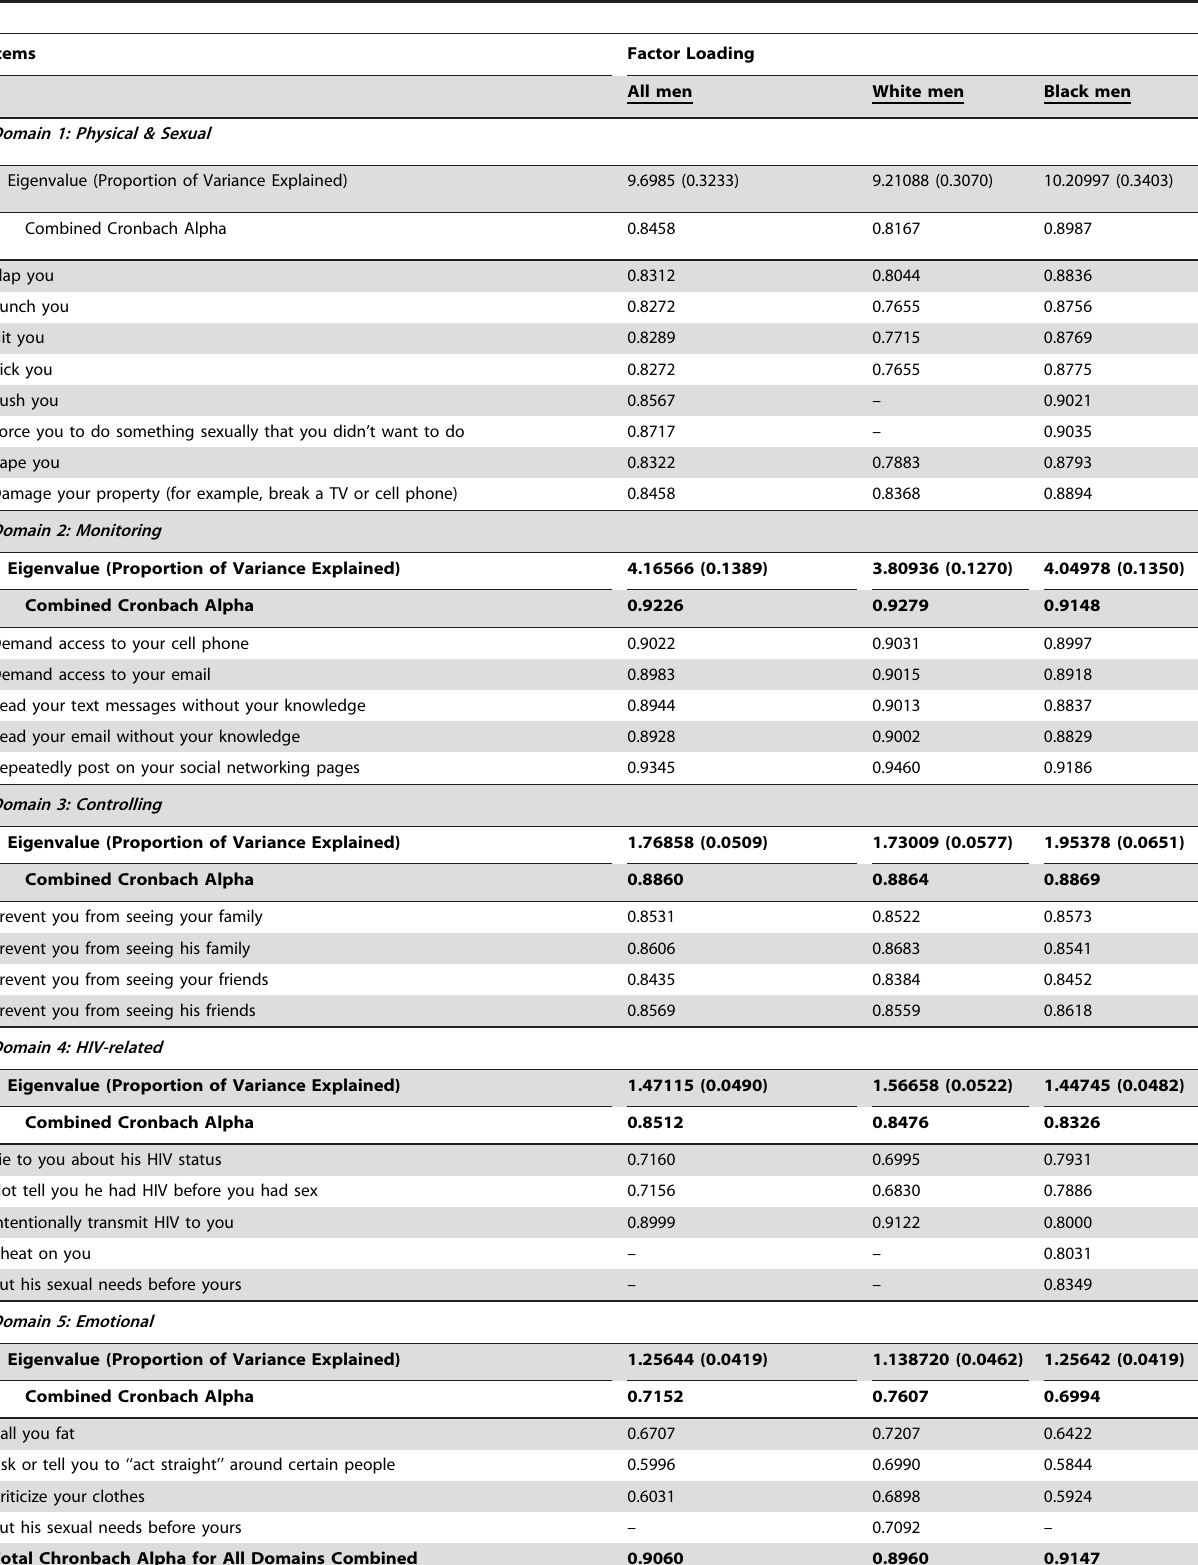
Table 3. Factor analysis of definitions of intimate partner violence among gay and bisexual men.